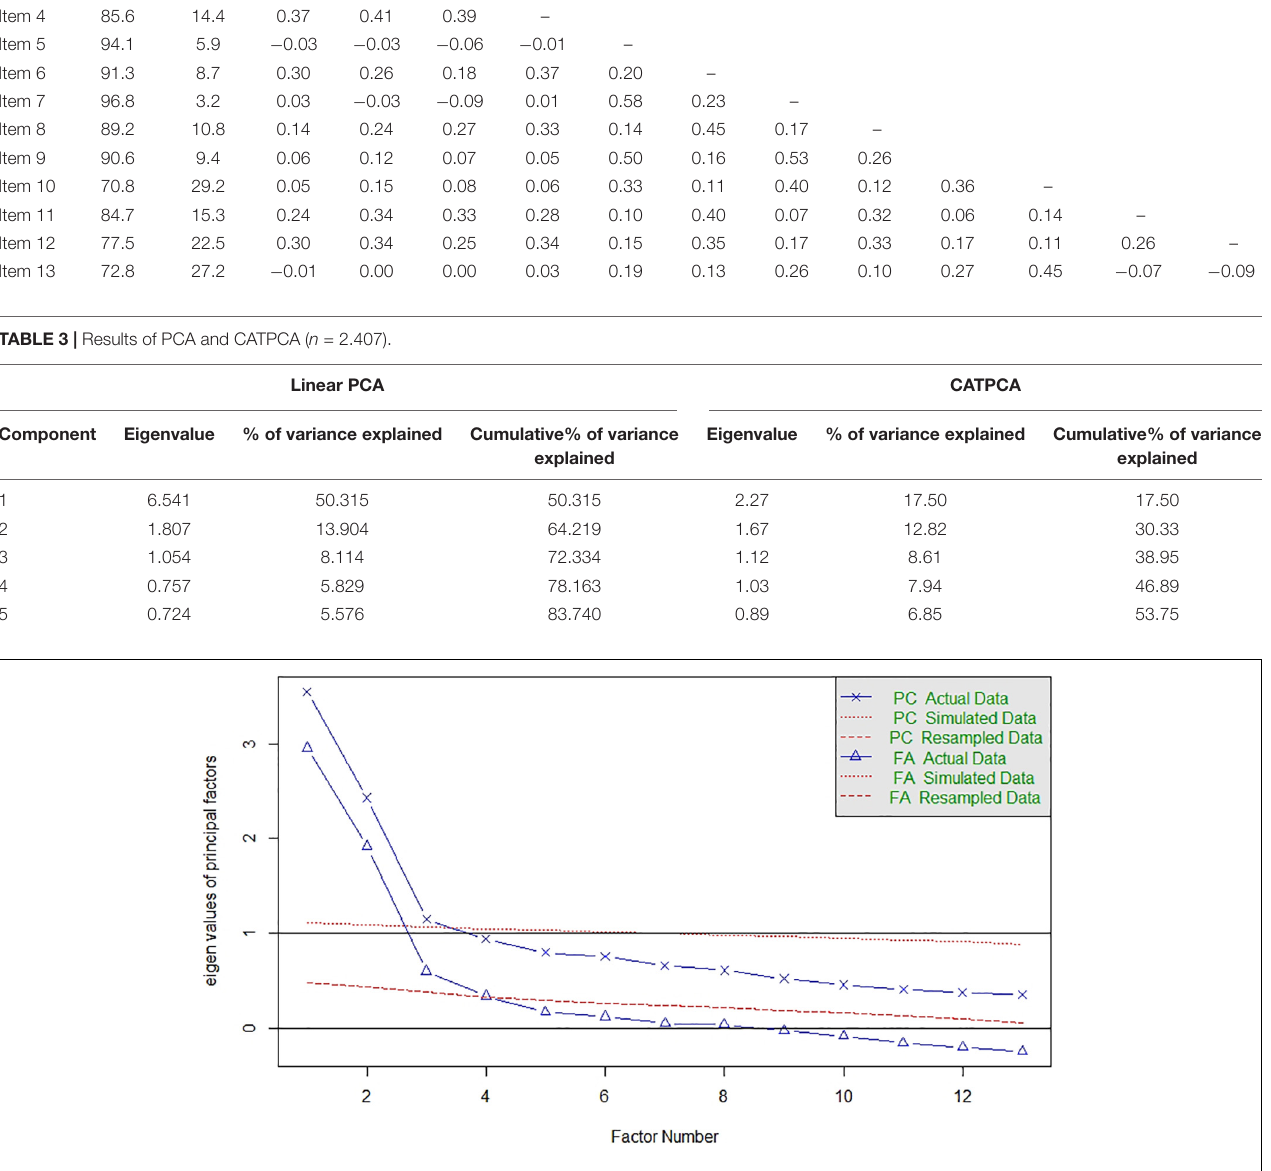
FIGURE 2 | Scree plot and parallel